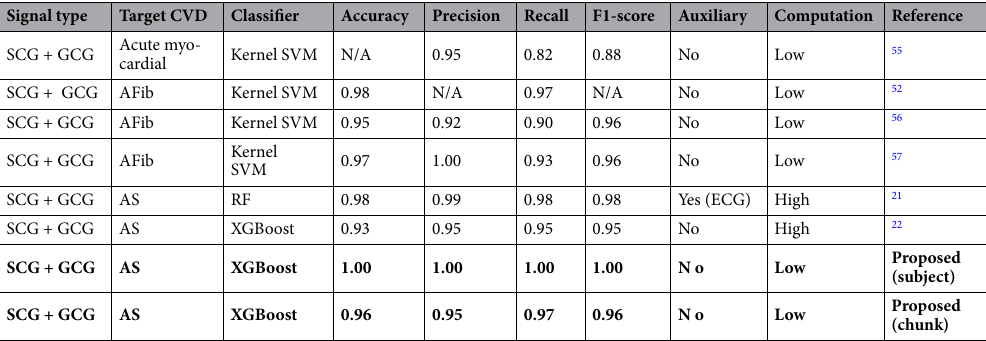
Table 7. Comparison of the model with previous works in the literature. Significant values are in